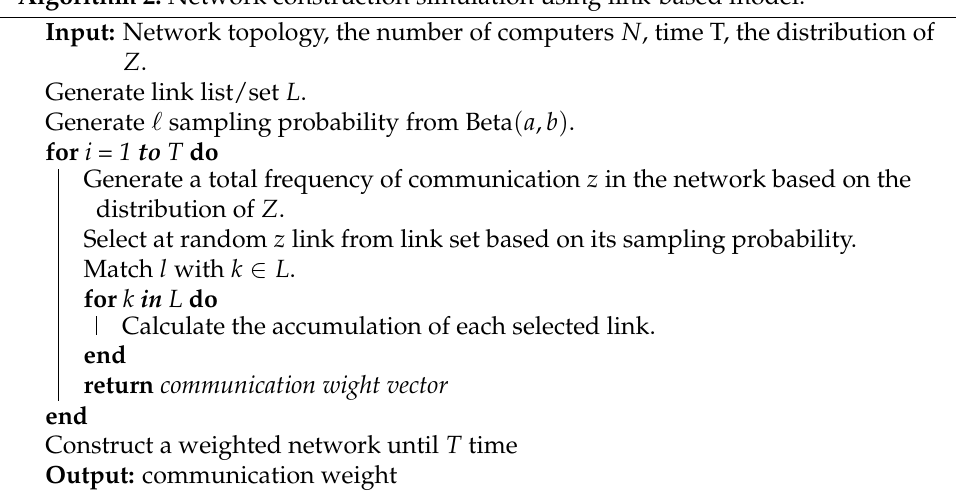
Algorithm 2: Network construction simulation using link-based